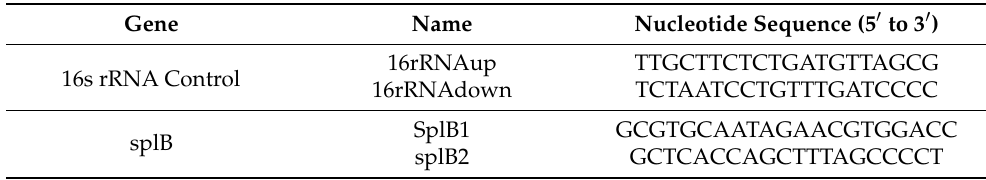
Table 4. Primer sequences for qRT-PCR.